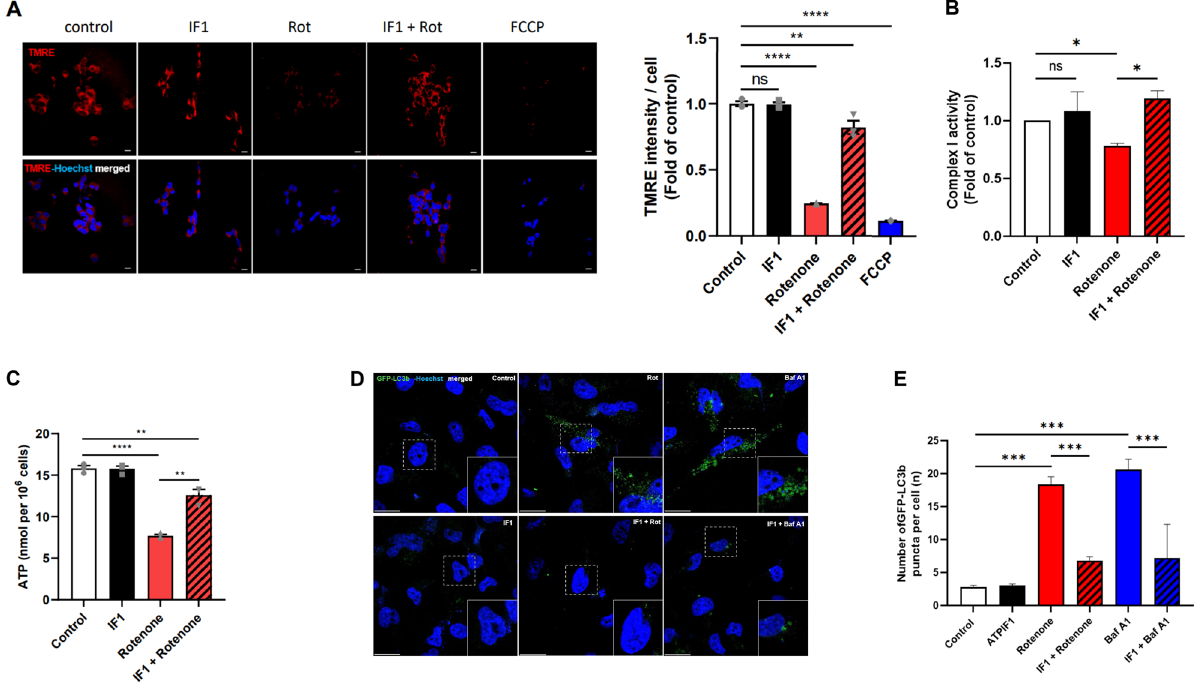
Figure 1. Treatment with IF1 protects mitochondria against a PD-like challenge in vitro. SH-SY5Y cells were treated with 1 µM rotenone, 100 nM IF1, or a combination of both for 24 h. ( A ) Representative confocal images of TMRE stained SH-SY5Y cells. Red: TMRE; Blue; Hoechst. Scale bar = 20 μm. A bar graph indicates the quantification of mean fluorescence intensity of TMRE normalized to the number of cells in each group. ( B ) SH-SY5Y cells were treated as indicated, and Complex I activity was detected and presented as a bar graph. ( C ) SH-SY5Y cells were treated as indicated, and intracellular ATP level was detected and presented as a bar graph. ( D ) GFP-LC3B expressing SH-SY5Y cells were treated with 1 µM rotenone, 100 nM IF1, 10 nM bafilomycin A1 (Baf A1) or a combination of them for 24 h. Green: GFP-LC3; Blue: Hoechst 33,342. Scale bar = 20 μm. ( E) A bar graph indicates the number of GFP-LC3B puncta per cell in each group. Data are expressed as mean ± SEM, n = 3. *p < 0.05, **p < 0.01, ***p < 0.001, ****p < 0.0001. ns not significant. One-way ANOVA with a Tukey’s post- hoc